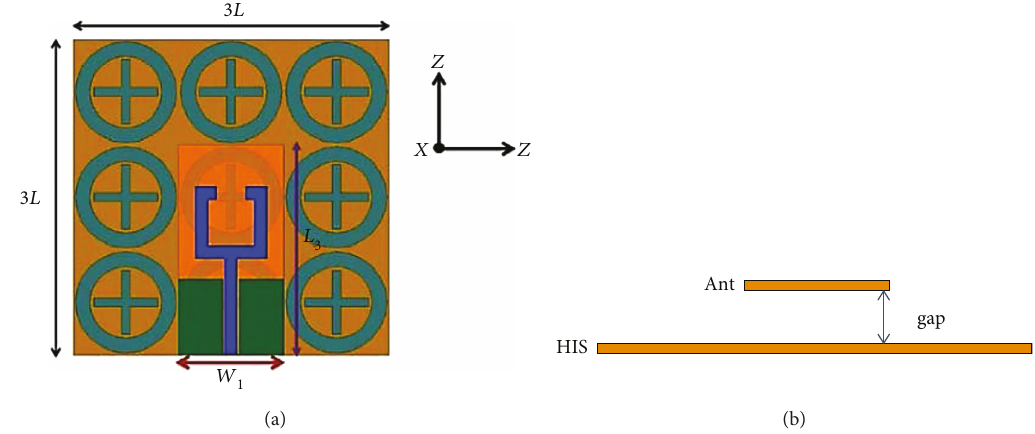
Figure 8: Two antennas, a dual-band high-impedance surface structure along with a monopole antenna [34].